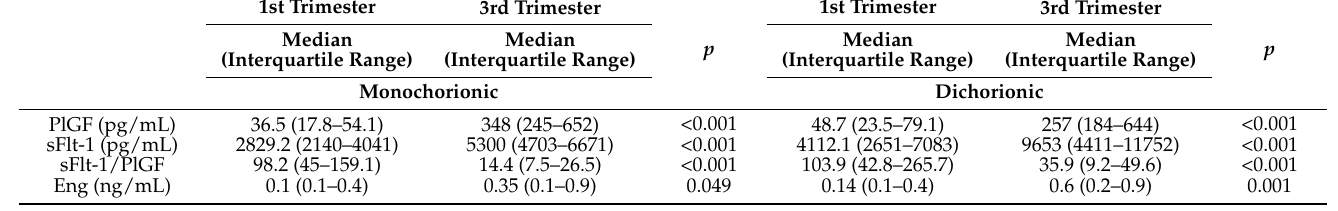
Figure 1. Box-and-whisker plots showing serum values of PlGF, sFlt-1, sFlt-1/PlGF ratio and sEng measured in the first trimester of twin pregnancy. ( a ) sFlt-1; ( b ) sEng; ( c ) PlGF; ( d ) sFlt-1/PlGF serum concentration.